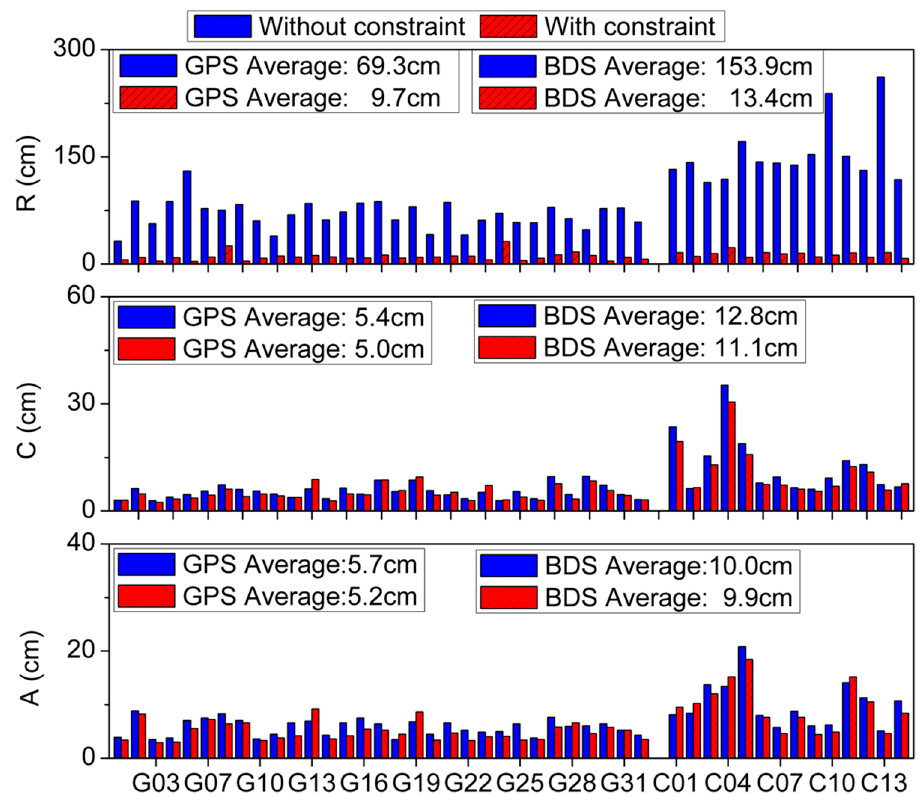
Figure 4. RMS of GPS and BDS orbit differences in the radial, cross-track and along-track directions of the clock-constrained and traditional RPPP POD solutions with respect to the dynamic POD solution. Table 2. Orbital dilution of precision (DOPs) for BDS and GPS satellites at 22:00:00, DOY 124,